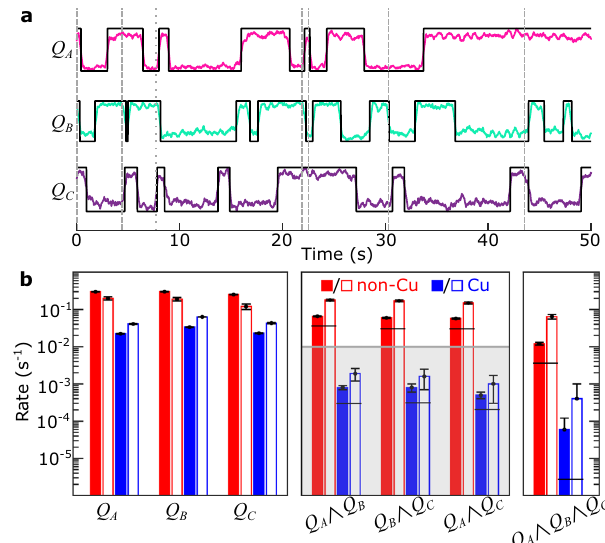
Fig. 4 | Correlated parity switches from background radiation. a Typical time trace of simultaneous QP parity measurements on non-Cu chip with no injection pulses. Black lines correspond to extracted digital signal from parity switches; vertical dashed (dotted) lines indicate double (triple) coincidences. b Observed parity switching rates (solid bars) and extracted poisoning event rates (open bars) fornon-Cu(red)andCu(blue)chipsintheabsenceofcontrolledphononinjection. Expected random background coincidence rates are plotted as horizontal black lines. Error bars computed from Poisson counting errors (see Supplementary Notes 10 and 11).Fault-tolerant level for two-fold correlated errors, asdescribed in the text, is indicated by gray-shaded